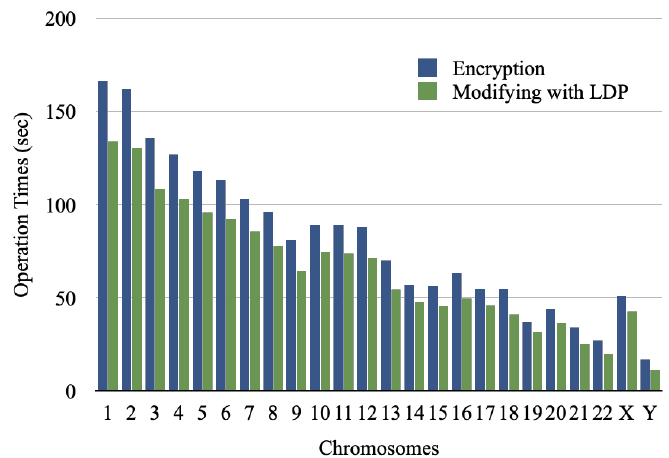
Figure 5. Results of operation times for encryption and modification with